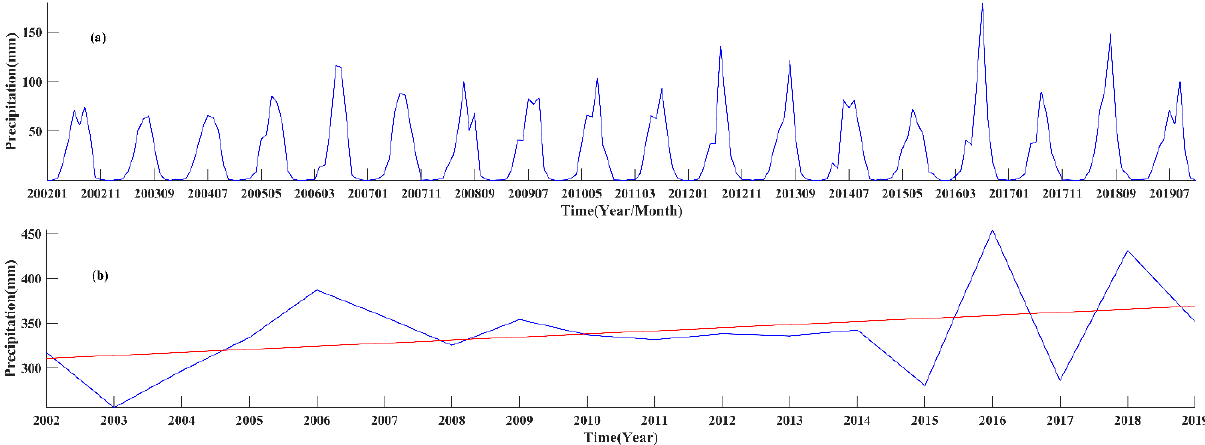
Figure 17. Precipitation on LQ from 2002 to 2019. ( a ) the variation of monthly cumulative precipita- tion. ( b ) the variation of annual average precipitation.